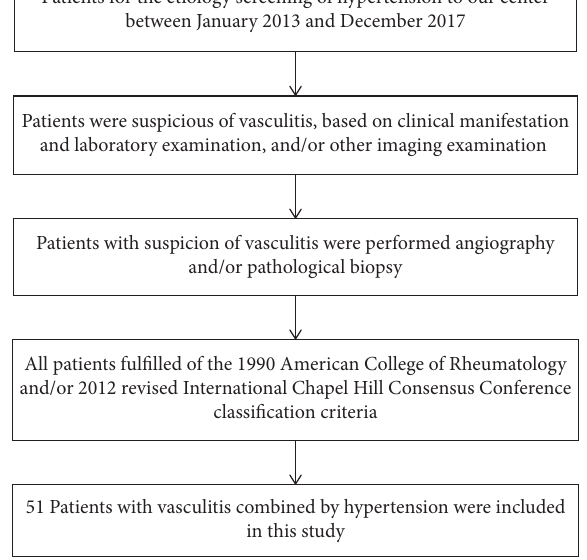
Figure 1: The screening and diagnostic flow chart for vasculitis combined with